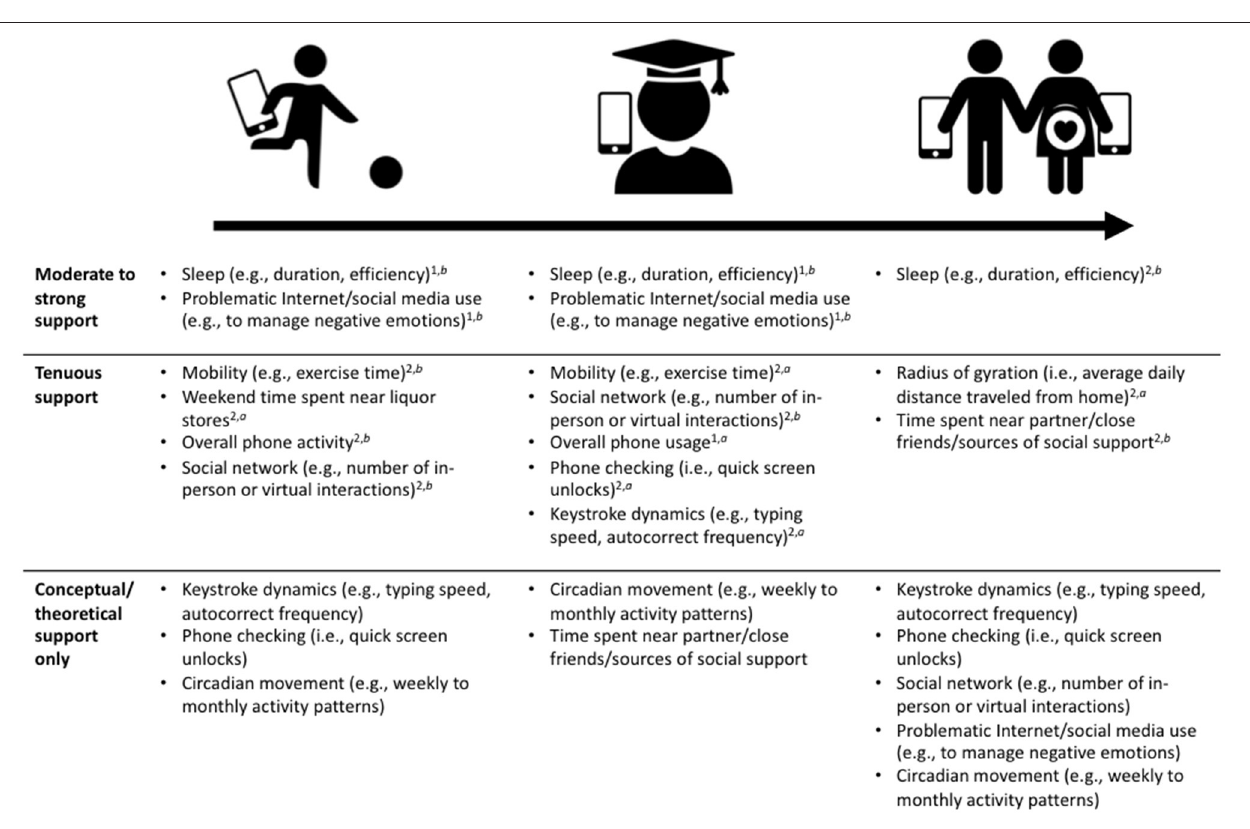
FIGURE 2 | Use of digital phenotyping summary measures as markers of emotion dysregulation across major lifespan transitions. Moderate to strong empirical support: > 2 peer-reviewed studies. Tenuous empirical support: 1–2 peer-reviewed studies. Conceptual/theoretical support only: author perspective, important measures for future study. 1 Use of this variable has been supported by at least one study demonstrating its association with a “gold standard” emotion regulation measure (e.g., affective lability, difficulty controlling emotions). 2 Use of this variable is supported by evidence of its association with indirect markers of emotion dysregulation (e.g., depression, anxiety, well-being). a Cited study (or studies) gathered evidence through smartphone-based passive monitoring. b Evidence acquired without passive monitoring. Note: no notation used for the last row because these items are not currently backed by evidence, representing the authors’ perspective